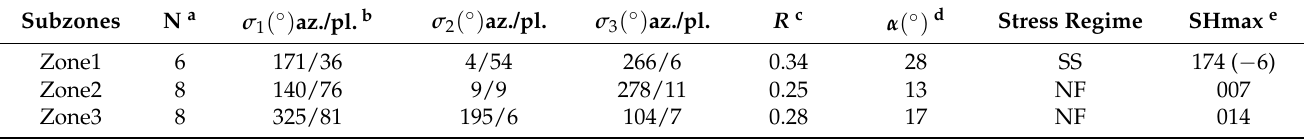
Table 4. Stress tensor parameters as obtained from focal mechanisms inversion.